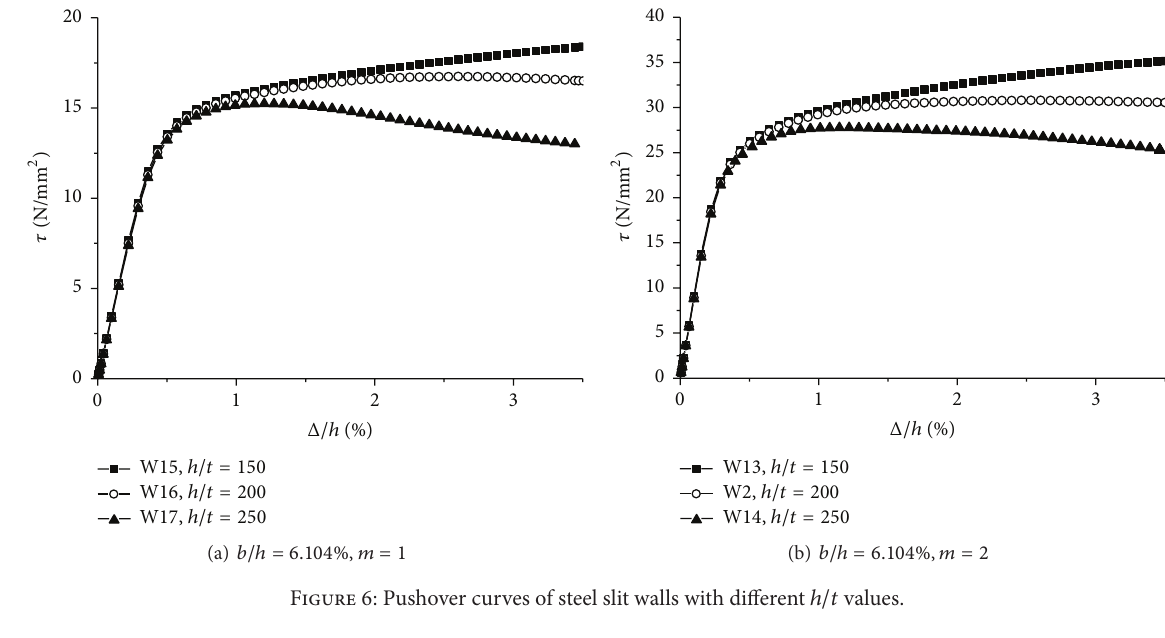
Figure 6: Pushover curves of steel slit walls with different ℎ/𝑡 values.